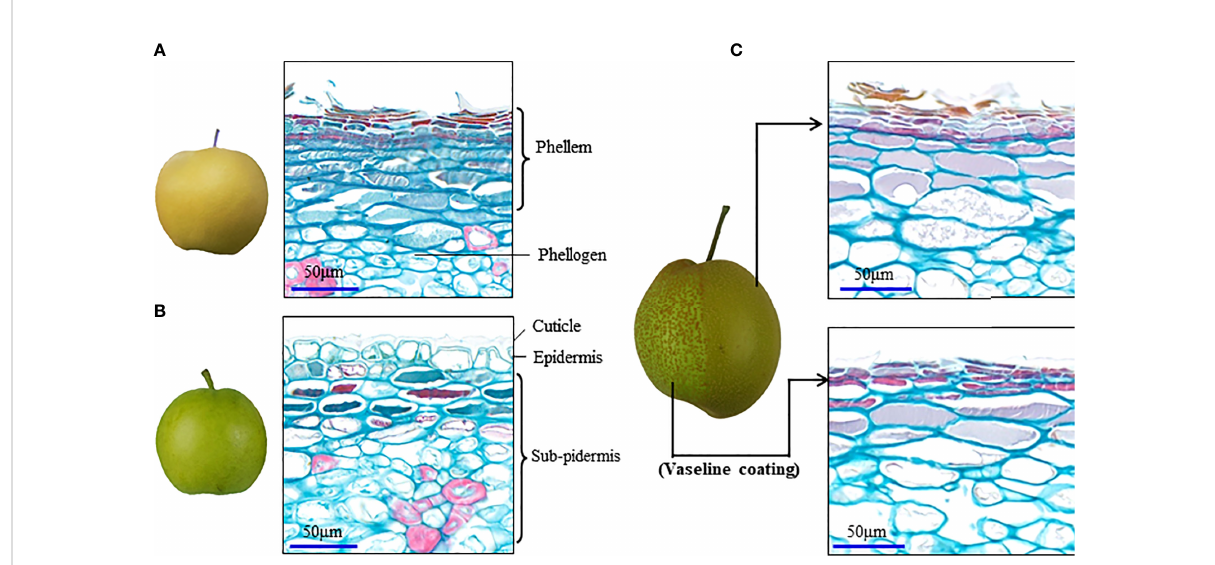
FIGURE 1 Vaseline coating repressed periderm development in the russet fruit skin of sand pear. (A, B) Naturally different periderm development between russet and green fruit skin of sand pear after 80 days of anthesis in normal growth conditions. (C) Vaseline coating on part of the fruit skin of sand pear that repressed the periderm development in the treatment